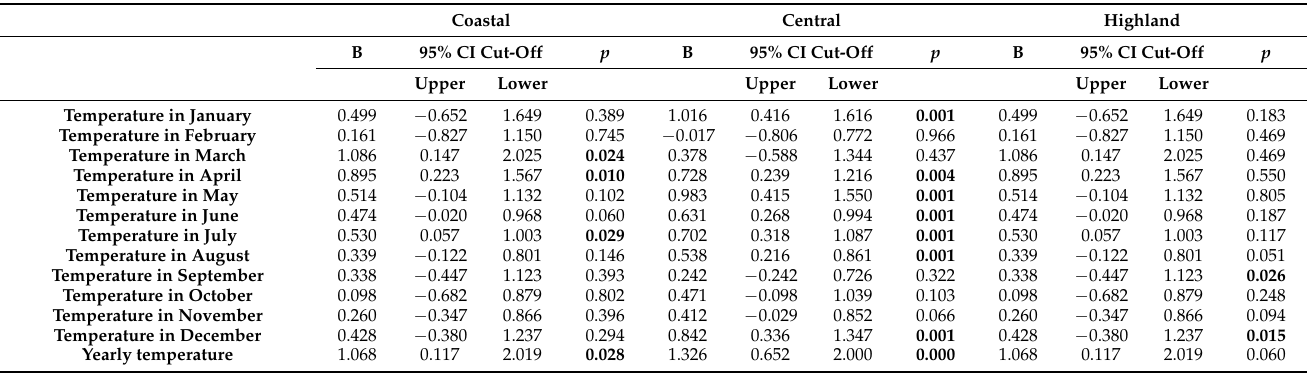
Table 1. Association between the number of cases of leishmaniosis and air temperature (%) in coastal, central, and highland Montenegro. Coastal Central Highland B 95% CI Cut-Off p B 95% CI Cut-Off p 95% CI Cut-Off p Upper Lower Upper Lower Upper Lower